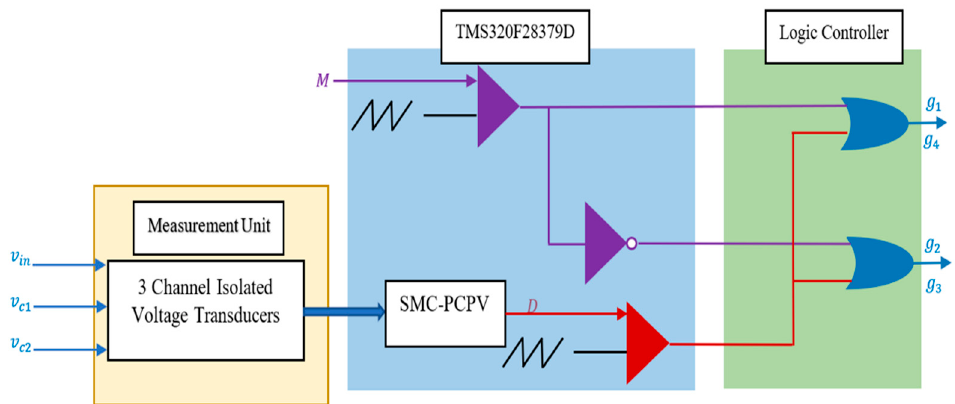
Table 2. Parameters of the PV array at T = 25 °C and 𝐺 = 1 Sun.